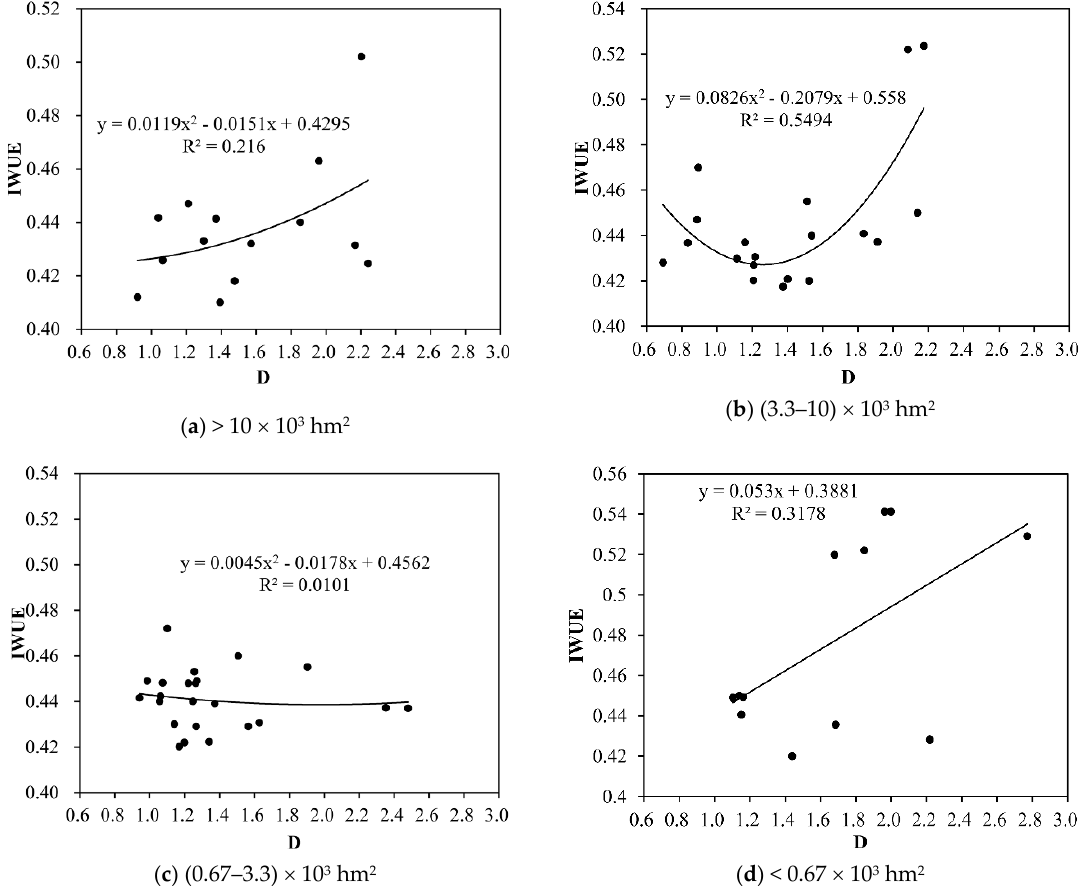
Figure 5. Scatter chart of IWUE and D values with canal systems presenting different irrigation district areas.